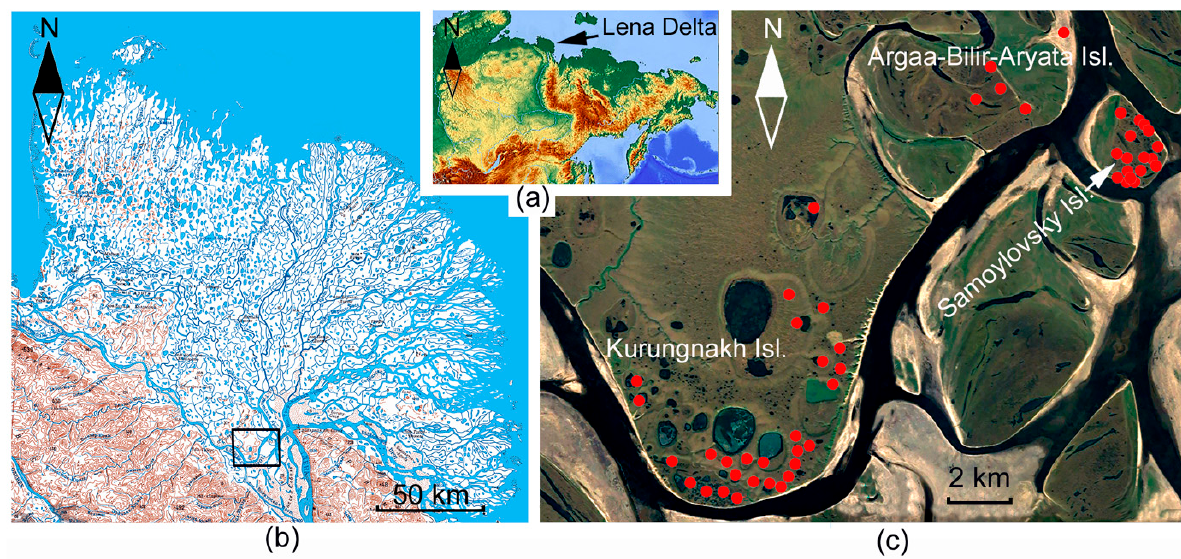
Figure 1. Map of northeastern Eurasia ( a ) with position of the Lena River Delta (arrow); Lena River Delta ( b ) with the location of the sampling area (black square); the sampling area ( c ) with the positions of sampling sites (red points).